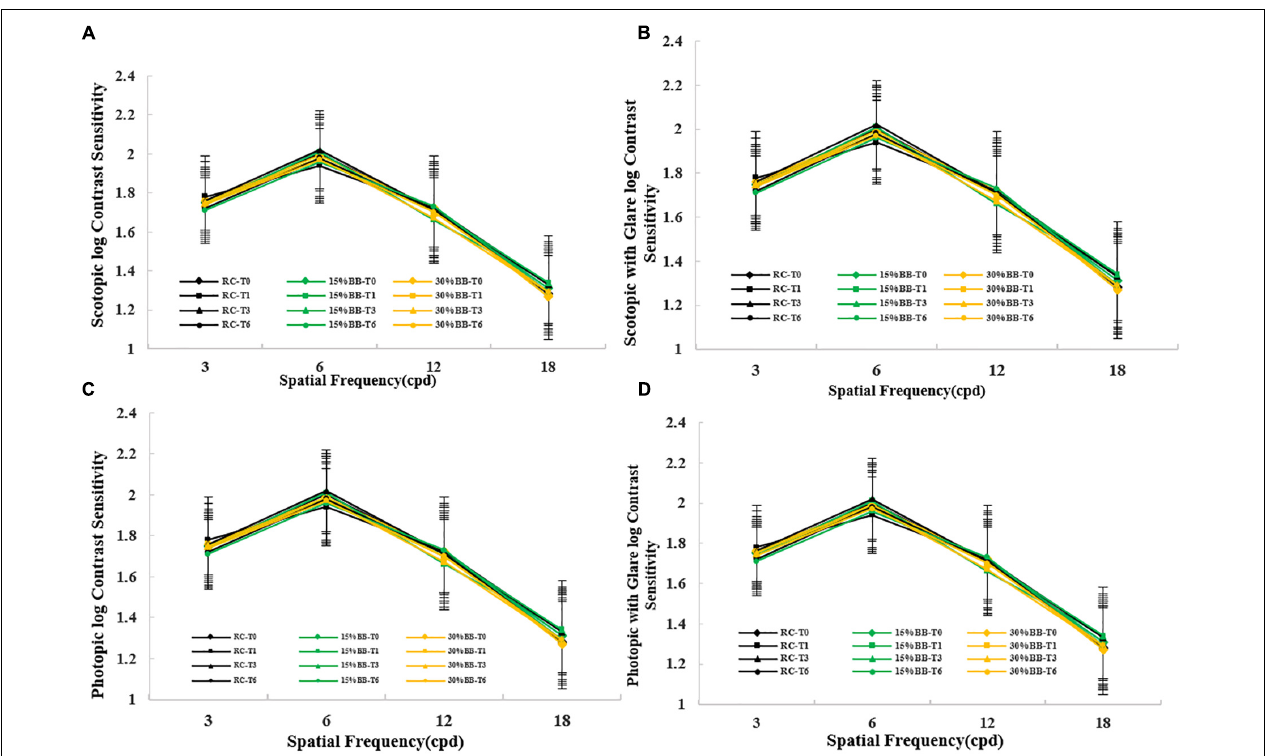
FIGURE 1 | Contrast sensitivity under four kinds of condition in various spatial frequencies at four time points for three types of spectacle lenses. Error bars represent standard errors. (A) Contrast sensitivity under scotopic condition; (B) Contrast sensitivity under scotopic condition with glare; (C) Contrast sensitivity under photopic condition; (D) Contrast sensitivity under photopic condition with glare. RC: regular clear lenses; 15% BB:15% blue-blocking spectacle lenses; 30% BB: 30% blue-blocking spectacle lenses. T0 = baseline; T1 = 1 month; T3 = 3 months; T6 = 6 months.